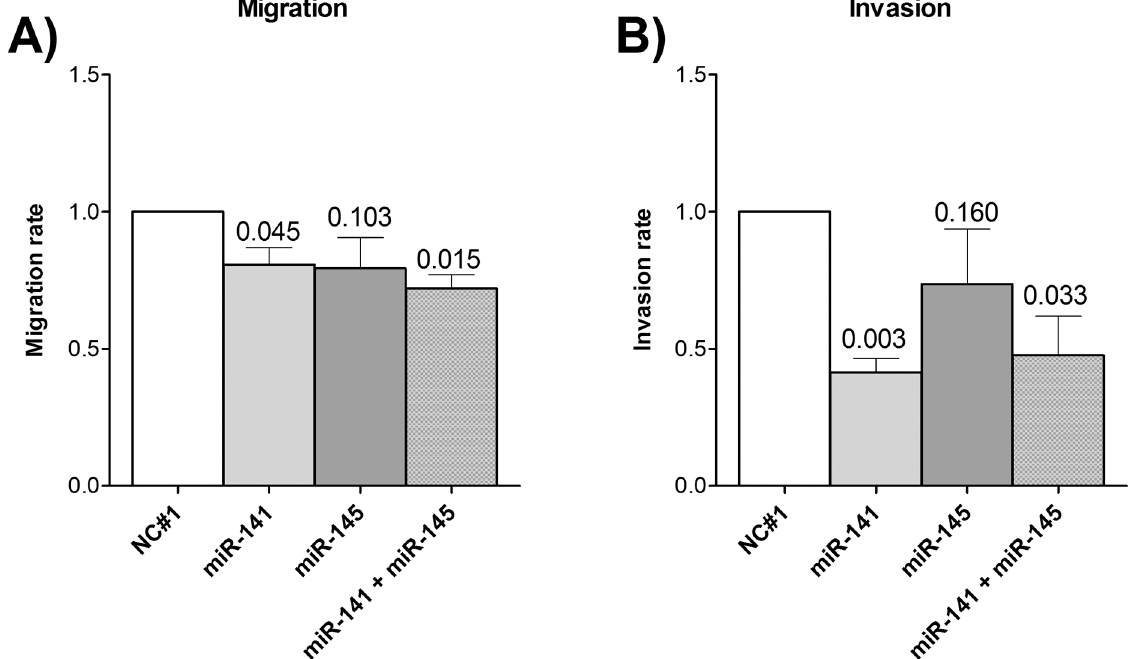
Fig 1. Effect of miRNAs on cell migration and invasion of renal cancer cell line 786-O. A) Cell migration and B) cell invasion of miRNA overexpressing 786-O cells were analyzed by a transwell assay. Migration/invasion rate is given in relation to negative control (mean ± SEM). P-values are given as numbers above bars. NC#1 = negative control; n = 3; t-test (one-tailed).